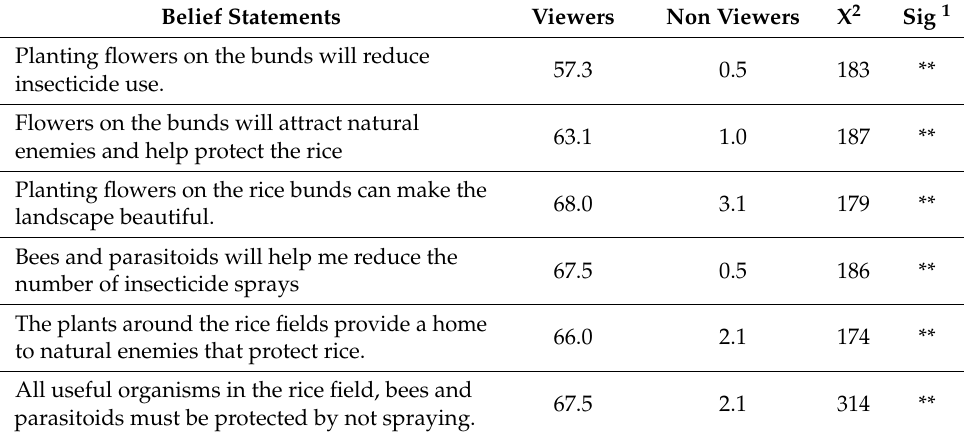
Viewers Non Viewers X 2